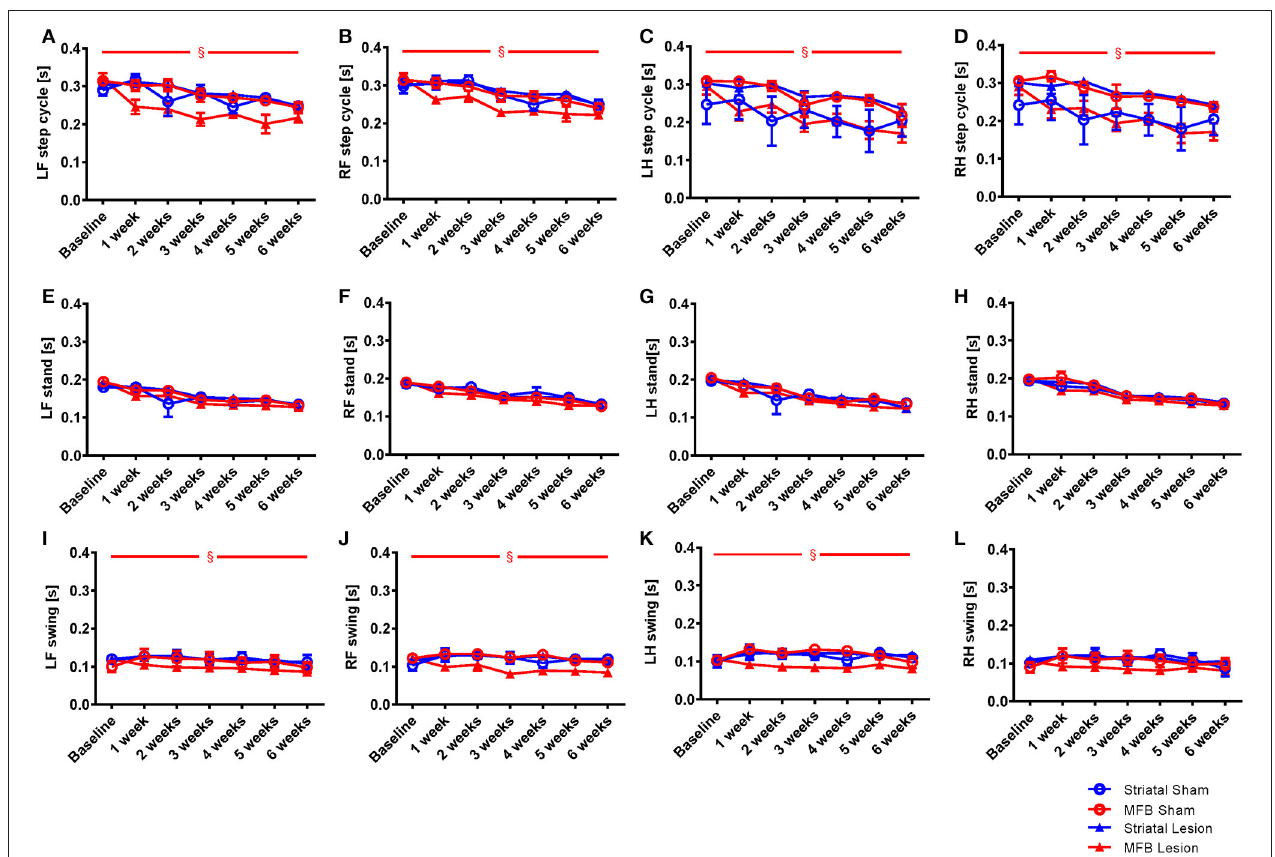
FIGURE 4 | Length of step cycle and its components stand phase and swing phase following MFB or striatal 6-OHDA lesioning. Graphs demonstrating: (A–D) the time in seconds between two consecutive initial contacts of the same paw (step cycle) and consists of the stand and swing phase; (E–H) the duration in seconds of contact of a paw with the walkway (stand); (I–L) the duration in seconds of no contact for a paw with the walkway (swing). LF, Left front; RF, right front; LH, left hind; RH, right hind. Data shown as mean ± s.e.m. (Two-way repeated measures ANOVA). § Influence of the treatment factor independently, when comparing the four different